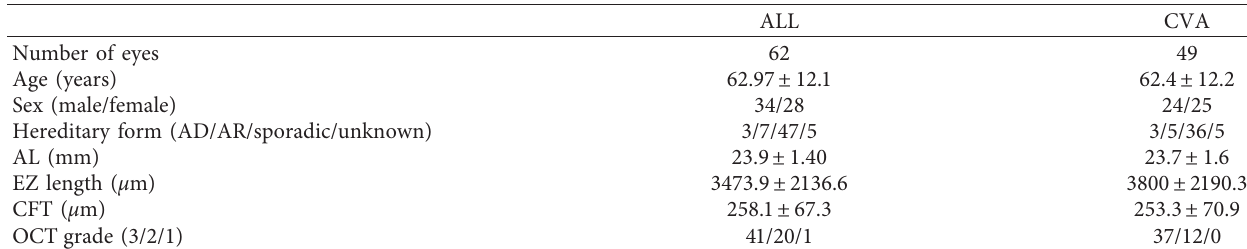
Figure 1: Representative results of macular integrity assessment (MAIA) microperimetry for patients with retinitis pigmentosa before (a) and after (b) cataract surgery. Averaged values of the retinal sensitivities of the central 13 points (2 ° ) and 37 (10 ° ) points were determined. Table 1: Patient demographics.